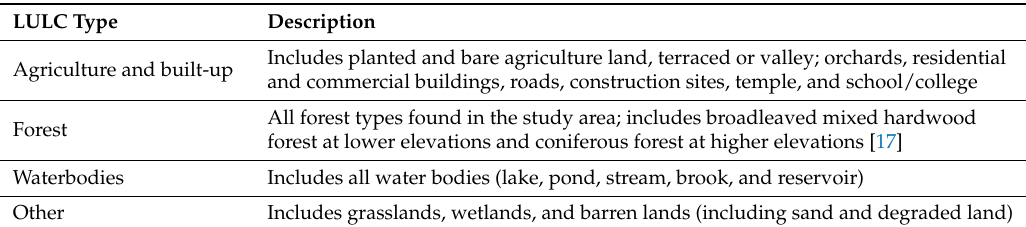
Table 2. Land-use and land-cover classification